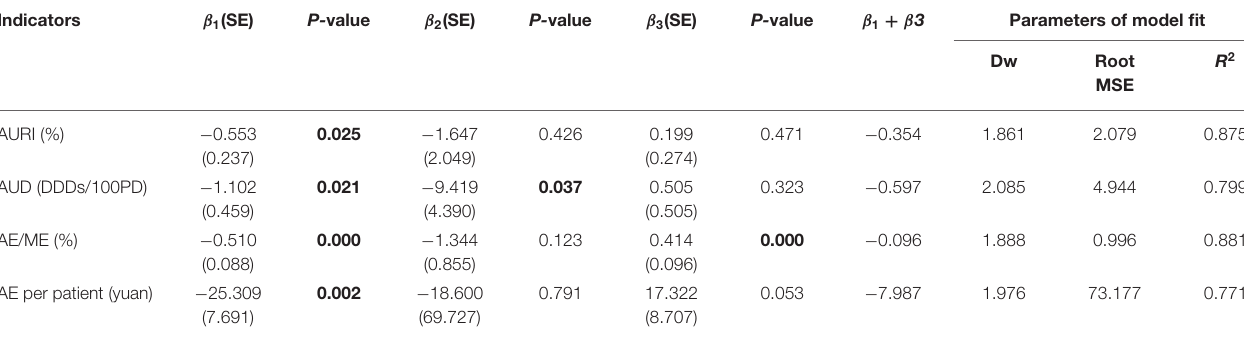
TABLE 6 | ITS analysis of inpatient antibiotic use.